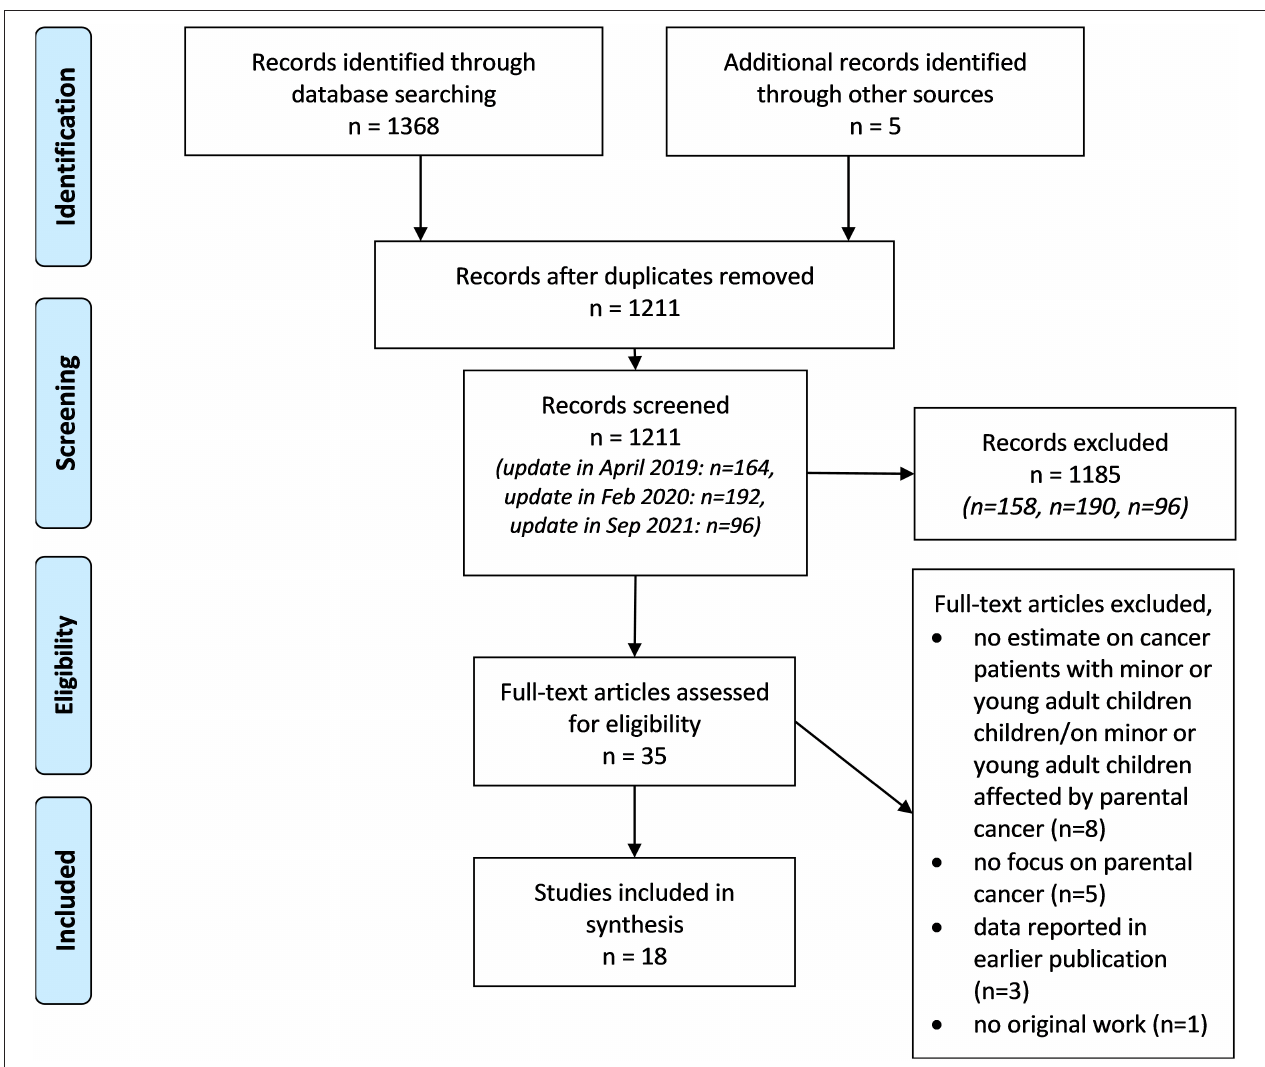
FIGURE 1 | Flow diagram for study selection and reasons for